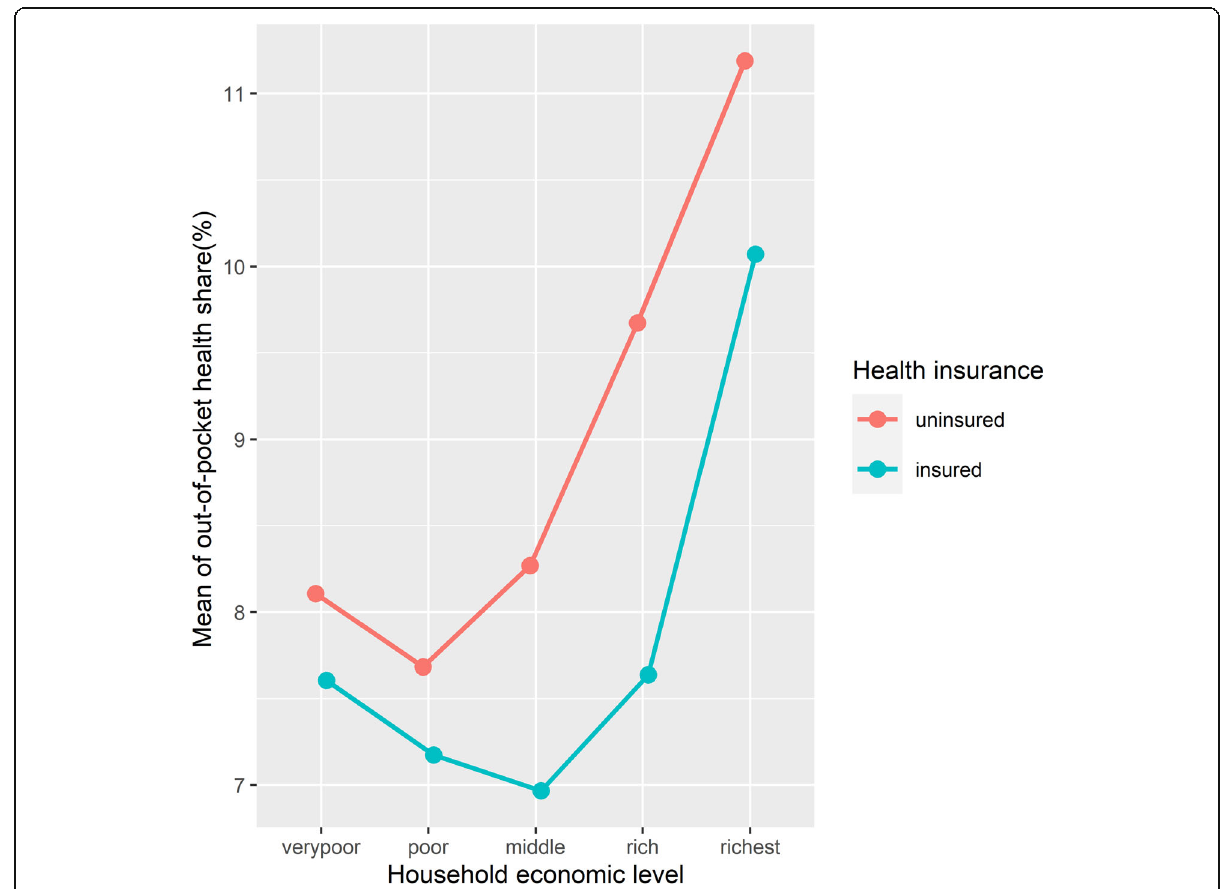
Fig. 4 The mean out-of-pocket health share by economic level and health insurance status of household